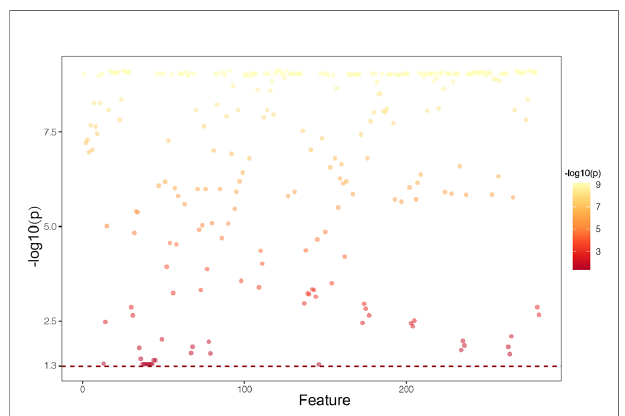
FIGURE 2 | Manthattan plot showing p-values of 282 radiomics features that exhibited signi fi cant difference between mucinous cystic neoplasm and atypical serous cystadenomas. P-values are adjusted for false discovery rate using